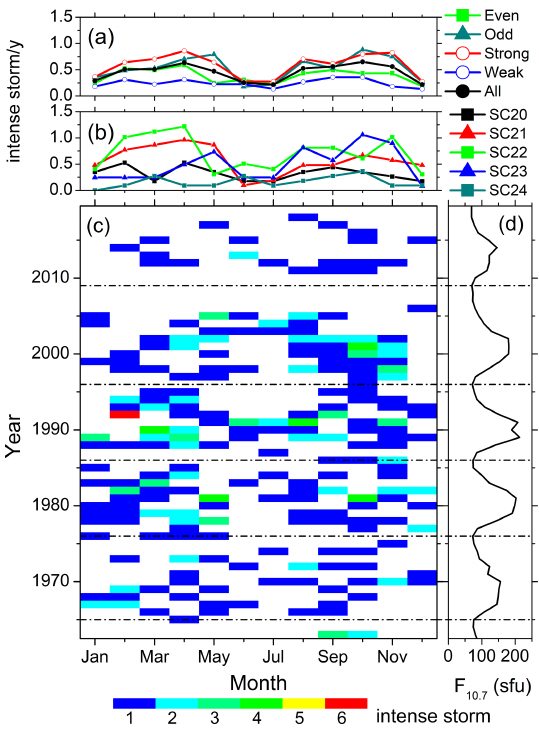
Figure 7. Geomagnetic Dst index variation from 1963 to 2019. Panel (c) shows the year–month contour plot of the mean Dst value in each month of the years 1963–2019. The values of different col- ors are given in the legend at the bottom. Data gaps are shown by crosses. Panel (d) shows the yearly mean F 10 . 7 solar flux. Panel (b) shows the monthly means of Dst during each solar cycles, and panel (a) shows the same during groups of the even, odd, strong, weak and all solar